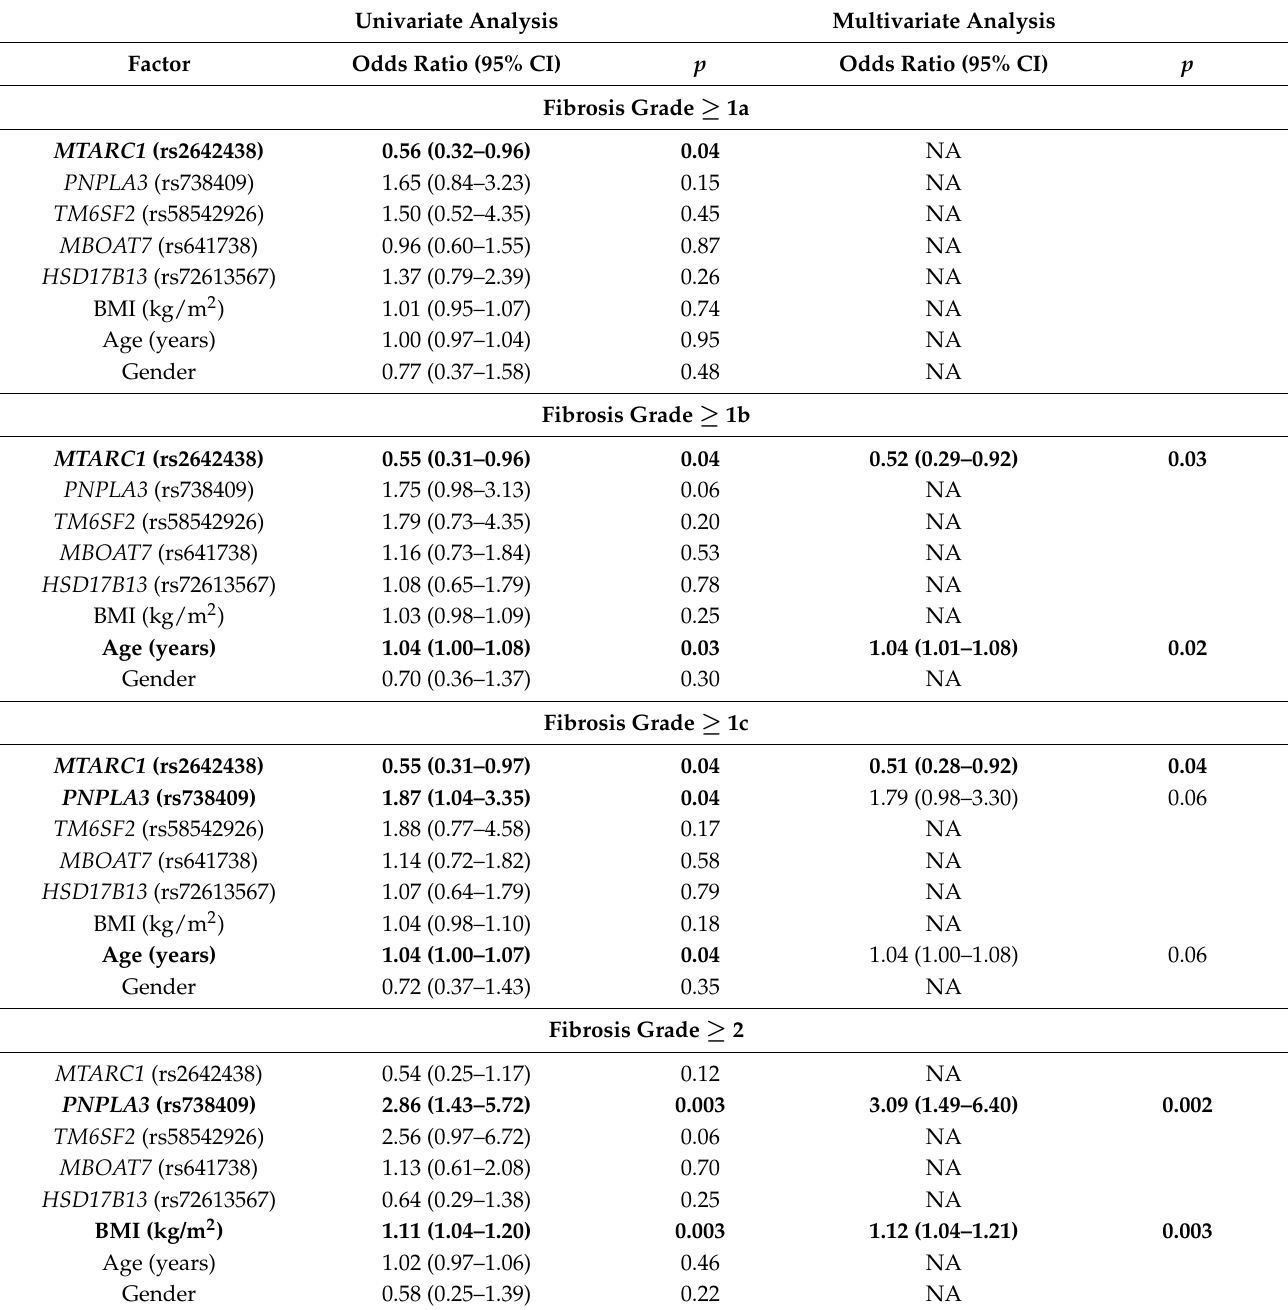
Table 4. Risk and protective factors for developing liver